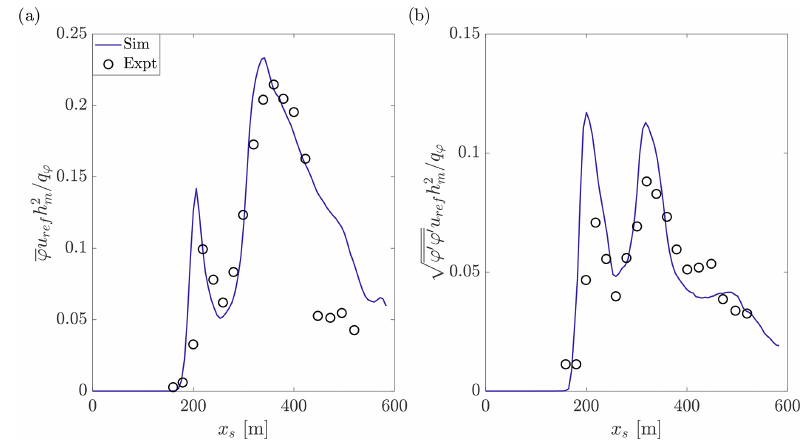
(cid:113) ϕ (cid:48) ϕ (cid:48) of the wind